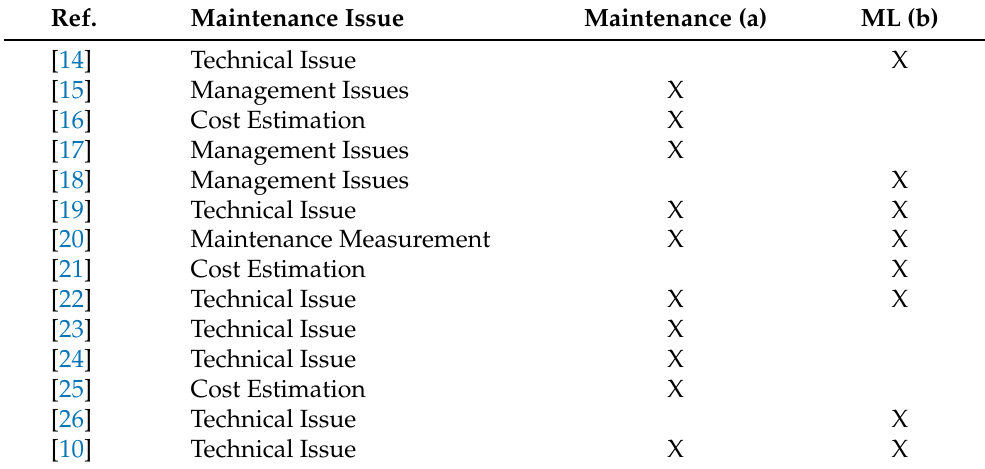
Table 1. RQs tackled in related